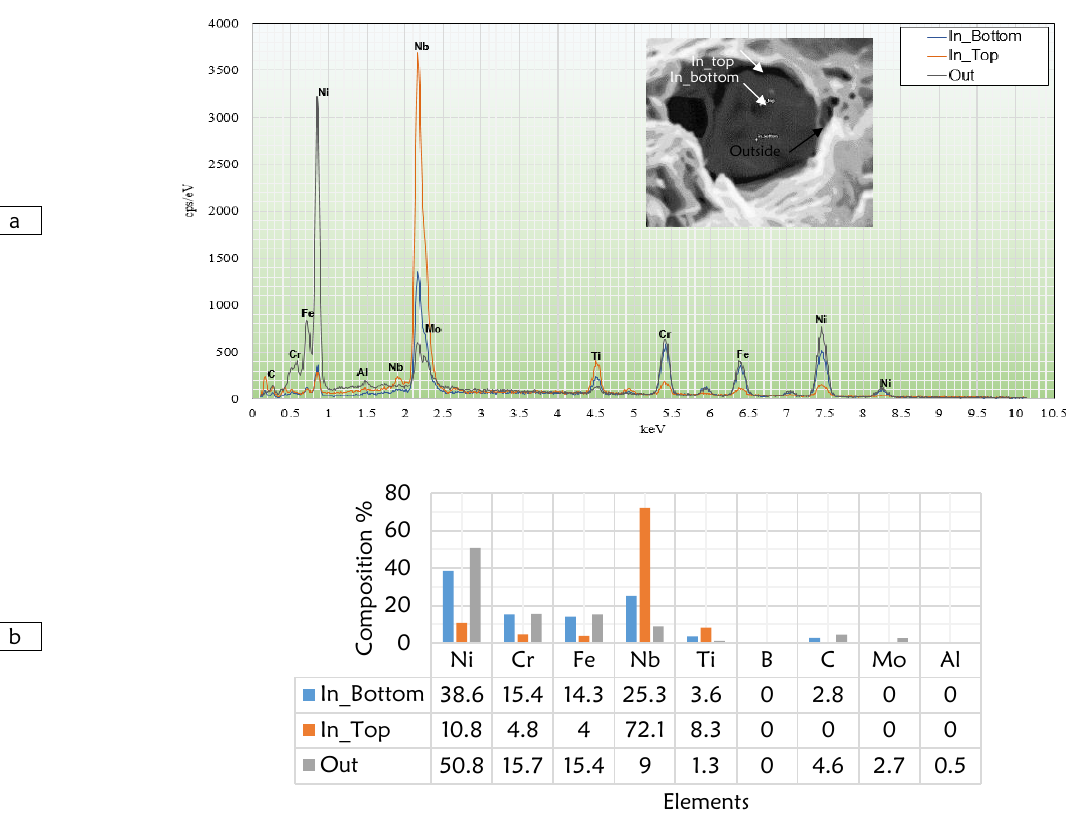
Figure 36: (a) Energy dispersive spectrums and chemical analysis of a Laves particle in SLM IN718. (b) The contrast in Ni and Nb contents of a Laves particles and its surrounded